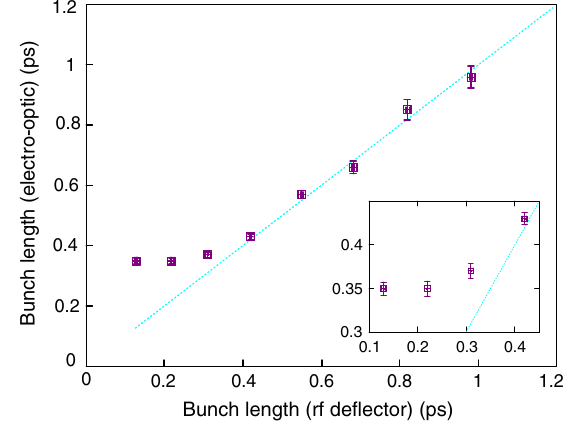
FIG. 52. Comparison of bunch length measurements obtained with the electro-optic monitor and the transverse deflecting rf